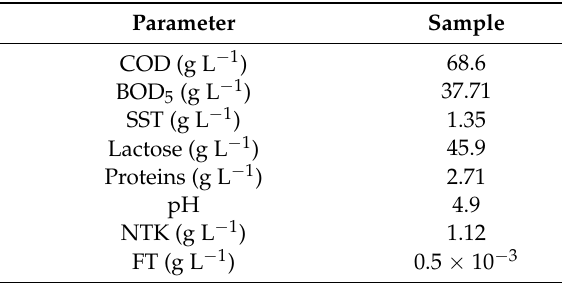
Table 2. Lactic serum chemical composition